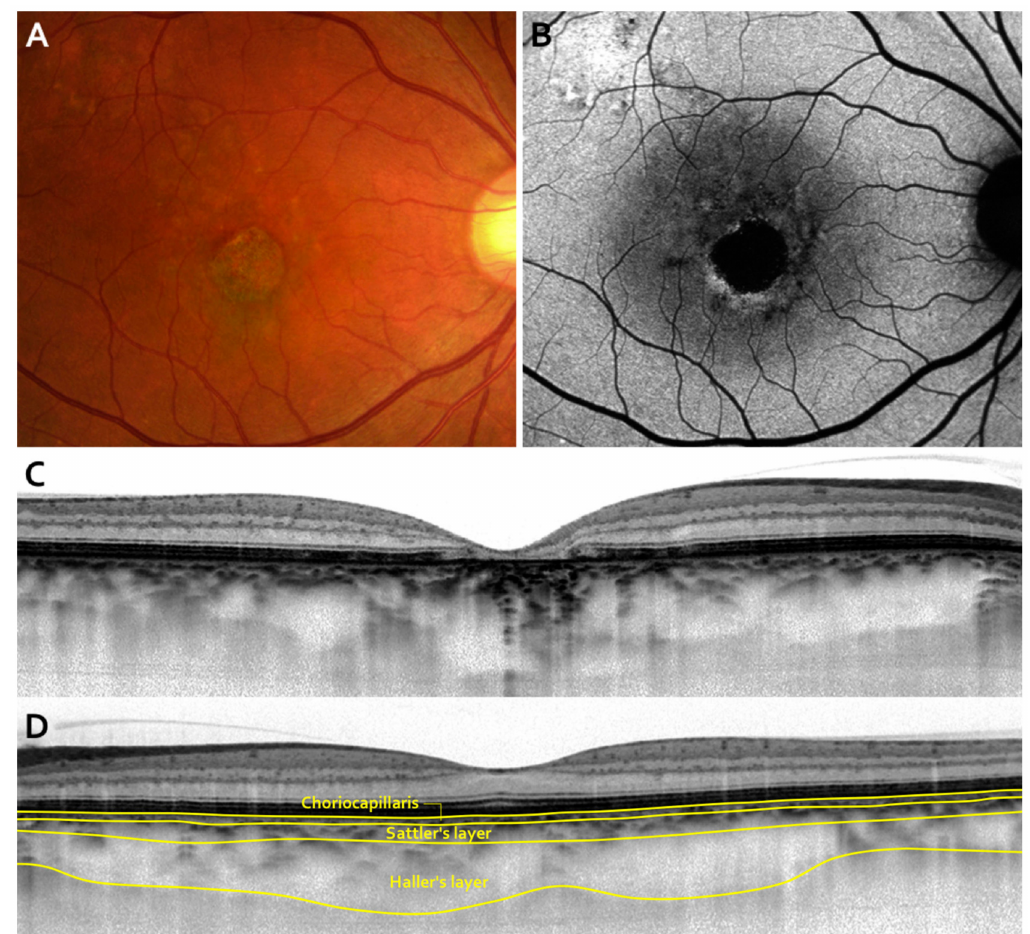
Figure 4. Typical images of pachychoroid geographic atrophy (GA) (modified from [146]). A color fundus photograph shows a reduced fundus tessellation without drusen and central GA ( A ). Fundus autofluorescence images showing hypoautofluorescent areas of GA with surrounding hyper-autofluorescent lesions ( B ). An optical coherence tomography (OCT) image showing markedly dilated large choroidal vessels with obliteration of the choriocapillaris ( C ). The outer nuclear layer is thin and the ellipsoid zone and retinal pigment epithelium bands are disrupted, corresponding to the GA area. An OCT image with thick choroid in the fellow eye. Choriocapillaris layer, Sattler’s layer, and Haller’s layer are indicated ( D